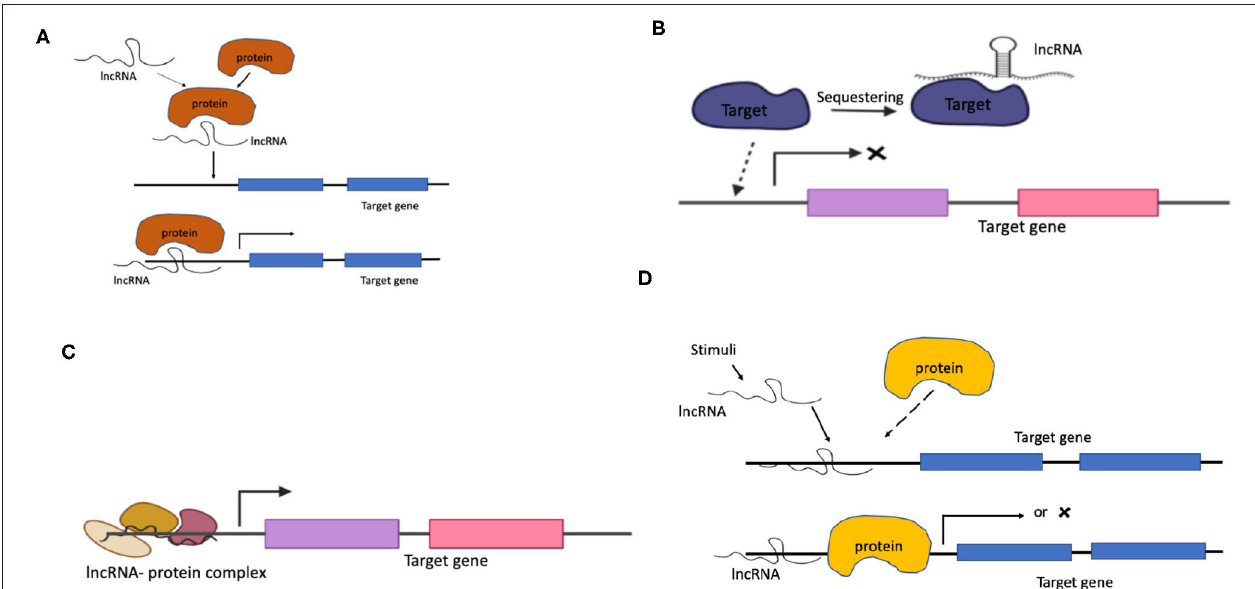
FIGURE 1 | Mechanisms of lncRNA. (A) Signals, (B) Guides, (C) Decoys, and (D)